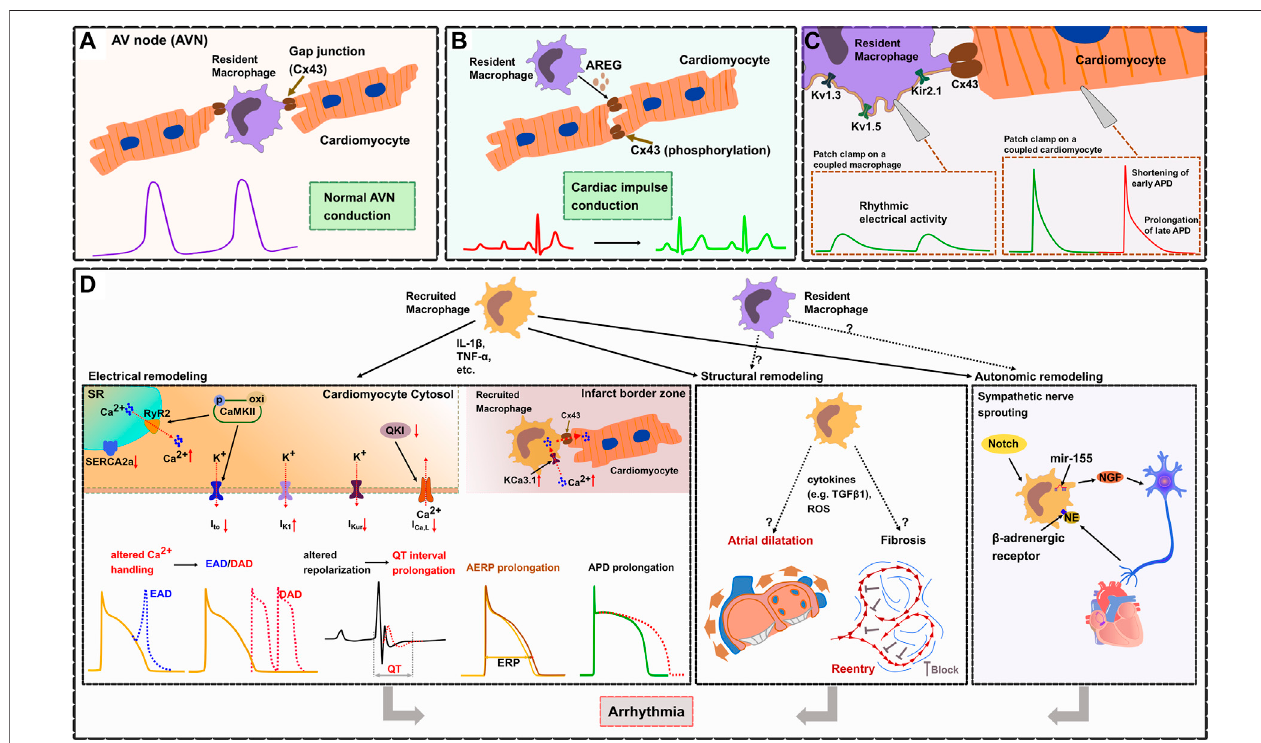
FIGURE 2 | Cardiac macrophages in electrophysiology and arrhythmogenesis. (A) . In the healthy heart, cardiac resident macrophages are functionally linked to cardiomyocytes through gap junctions (Cx43), thereby facilitating electrical conduction in the atrioventricular node (AVN). (B) . Macrophages prevent arrhythmias by regulating the phosphorylation of Cx43 via AREG (Amphiregulin). (C) . Resident cardiac macrophages express potassium channels (including Kv1.3, Kv1.5, and Kir2.1), Patch clamp experiments show that resident macrophages can depolarize coupled cardiomyocytes, shorten early APD and prolong late APD. (D) . Electrical remodeling (left frame). During in fl ammation, recruited macrophages produce cytokines (IL-1 β , TNF- α ) which affect ion currents and calcium homeostasis resulting in increased electrical vulnerability to arrhythmias. TNF- α causes abnormal SR Ca 2+ -ATPase (SERCA2a) function which reduces the SR Ca 2+ uptake. IL-1 β induces AP prolongationthroughadecreaseinI to currentandanincreaseddiastolicsarcoplasmicreticulum(SR)Ca 2+ leak via ryanodinereceptors(RyR2).Thisispromotedthrough CaMKII oxidation/phosphorylation causing cytosol Ca 2+ overload leading to delayed afterdepolarizations (DAD). CaMKII inactivates I to which contributes to the prolongation of APD and predisposes to early or delayed afterdepolarizations (EAD). IL-1 β reduces I Ca,L by inhibiting the expression of atrial quaking protein (QKI) facilitating atrial fi brillation. Cytokines (IL-1 β , TNF- α , TGF- β , IL-6) lead to APD prolongation by altering potassium current densities (increased I K1 and reduced I Kur ). Reduced atrial conduction velocity and AERP prolongation, also results in enhanced susceptibility for atrial fi brillation (AF). Within infarct border zones, upregulated potassium channel KCa3.1 in recruited macrophages facilitate Ca 2+ in fl ux into the macrophages. Elevated intracellular Ca 2+ then fl ows from recruited macrophages to adjacent cardiomyocytes via Cx43, which causes APD prolongation of cardiomyocytes. Structural remodeling (middle frame). Recruited macrophages cause atrial dilatation and fi brosis probably by releasing cytokines (e.g., TGF- β 1) or reactive oxygen species (ROS), but the exact mechanisms have not been fully elucidated. Atrial